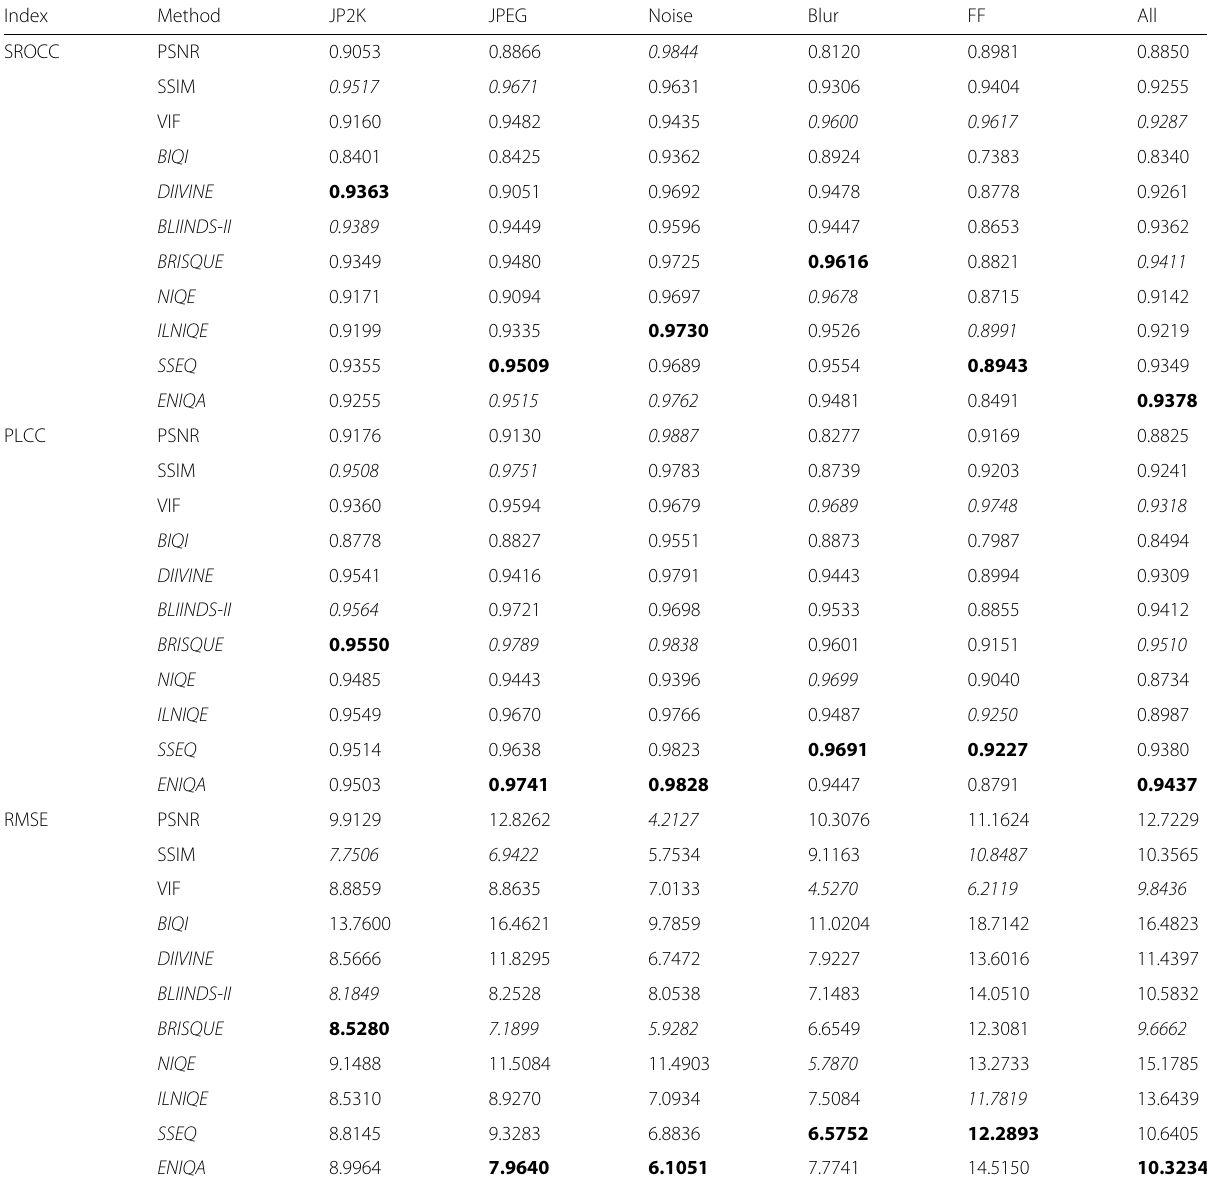
Table 4 Median SROCC/PLCC/RMSE values on the LIVE